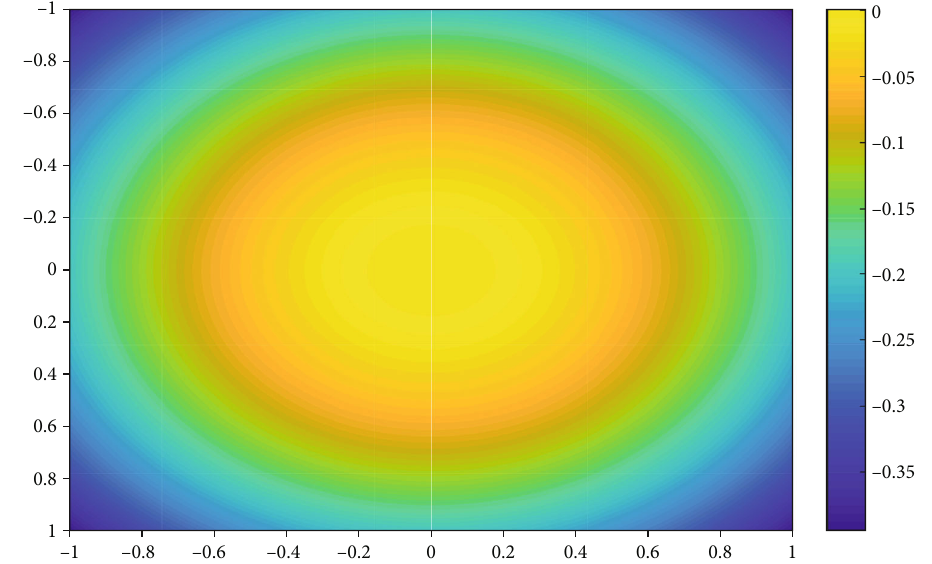
Figure 3: Errors of approximation of network operators (6) with n = 10000 . Table 1: The error values of e